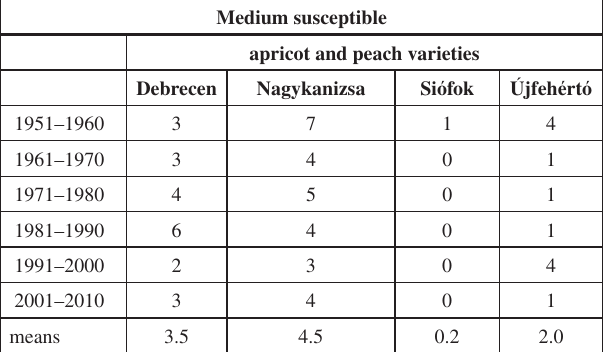
Table 6 – The frequency of signifi cant spring frost damages and its change for medium tolerant apricot and peach varieties (1951-2010)